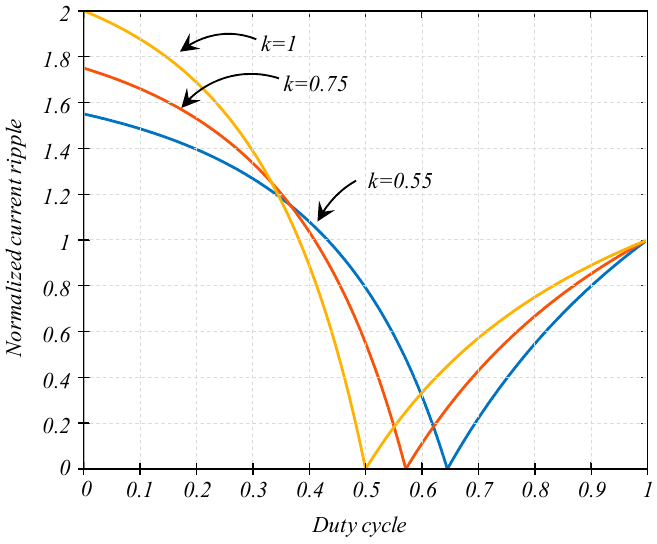
Figure 10. Normalized input current ripple vs. duty cycle.